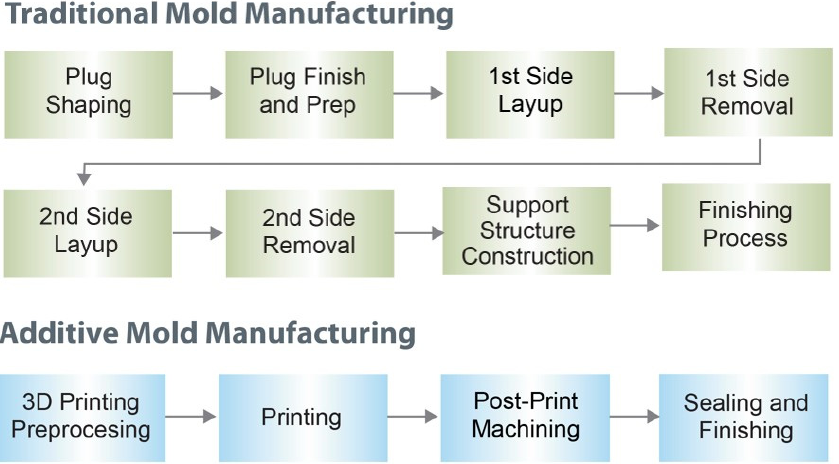
Figure 2. A comparison of the general process steps required to produce a traditionally manufactured composite mold vs. an additively manufactured composite mold.